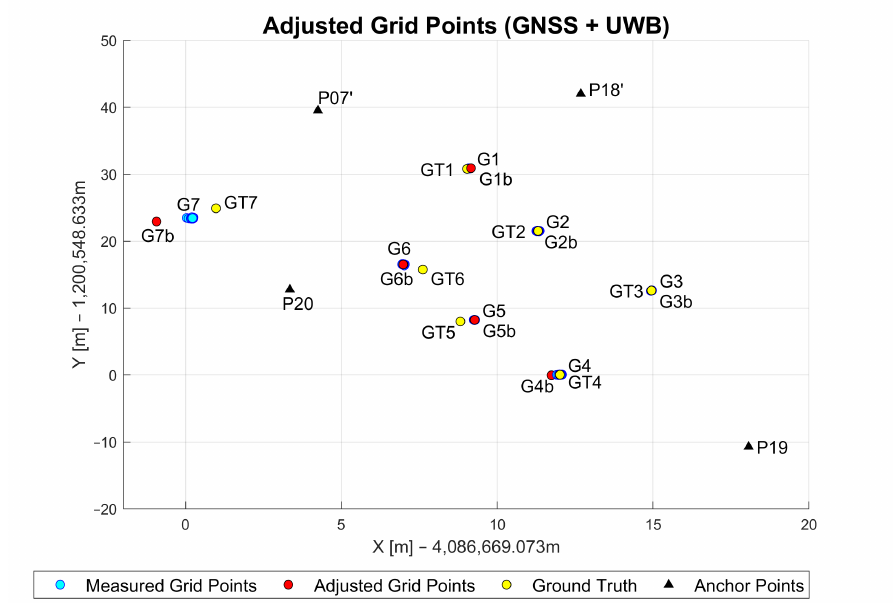
Figure 16. Adjusted, measured and ground truth grid point coordinates based on GNSS/UWB approach. Table 4. GNSS/UWB-fusion error statistics in (m). PNo. Avg. Median Max. Min. σ G1 0.161 0.165 0.077 0.234 0.034 G2 0.076 0.075 0.134 0.063 0.019 G3